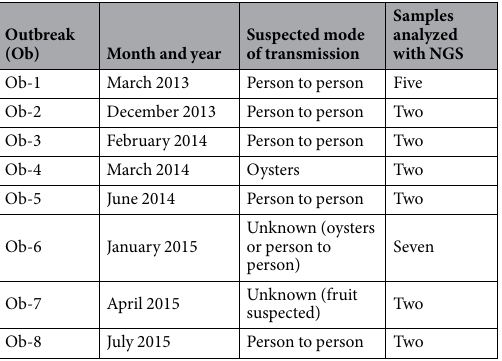
Table 3. Line-list of eight norovirus-associated outbreaks in Denmark 2013–2015. Legend: Column 1: Outbreak number in chronological order, Column 2: Month and year of the outbreak, Column 3: Suspected mode of transmission, Column 4: Number of samples analyzed with